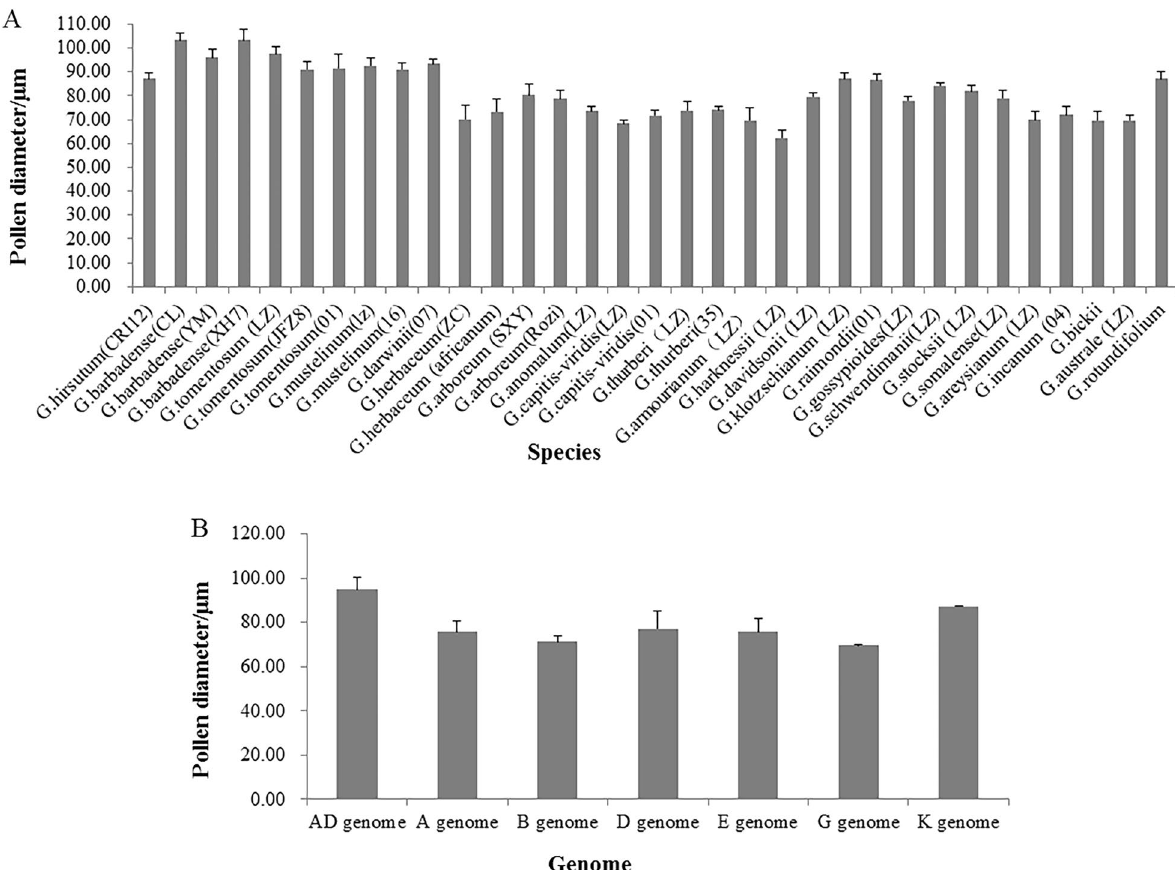
Fig. 2 The diameter of pollen in the Gossypium species. A Comparison of pollen diameter among Gossypium species. B Comparison of pollen diameter among different genomes of Gossypium